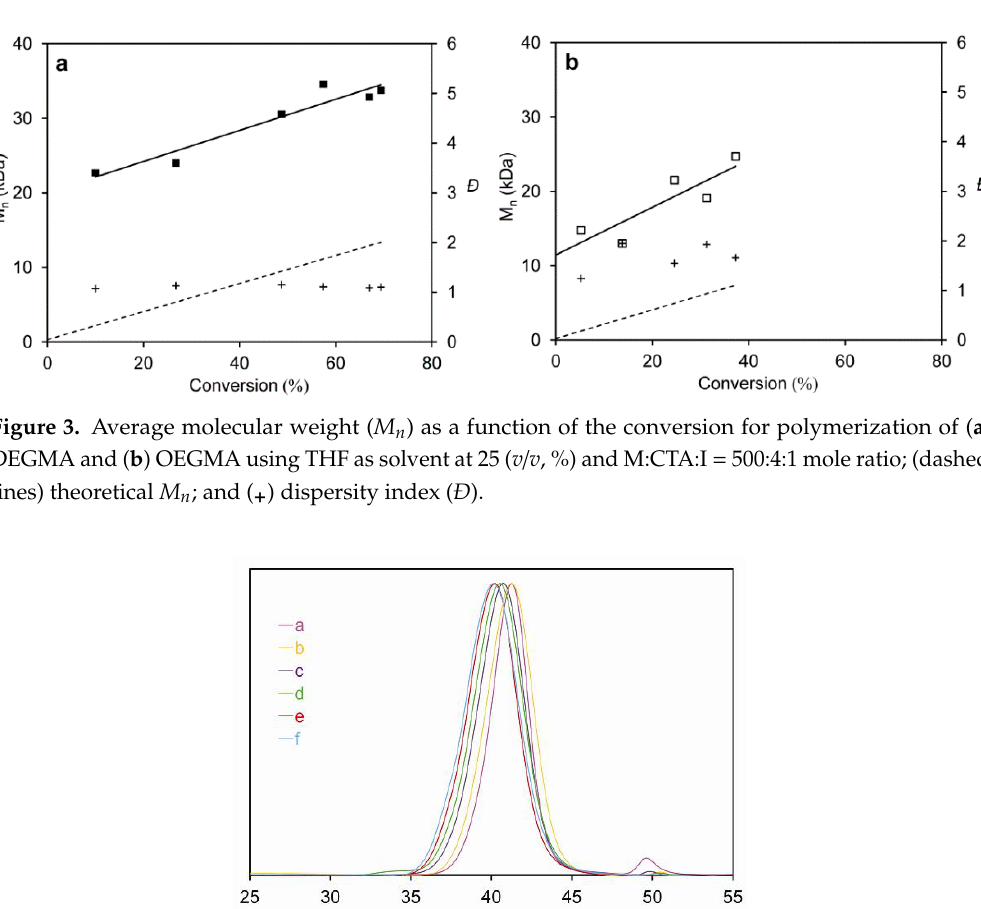
Figure 2. ( a ) Conversion as a function of time for ( ■ ) DEGMA and ( □ ) OEGMA using THF as solvent at 25 ( v / v , %) and M:CTA:I = 500:4:1 mole ratio and ( b ) pseudo-first order kinetic plot for ( ■ ) DEGMA